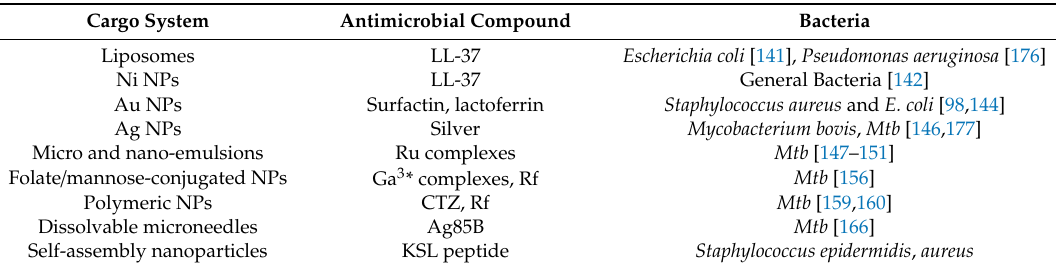
Table 2. Most common antimicrobial delivery